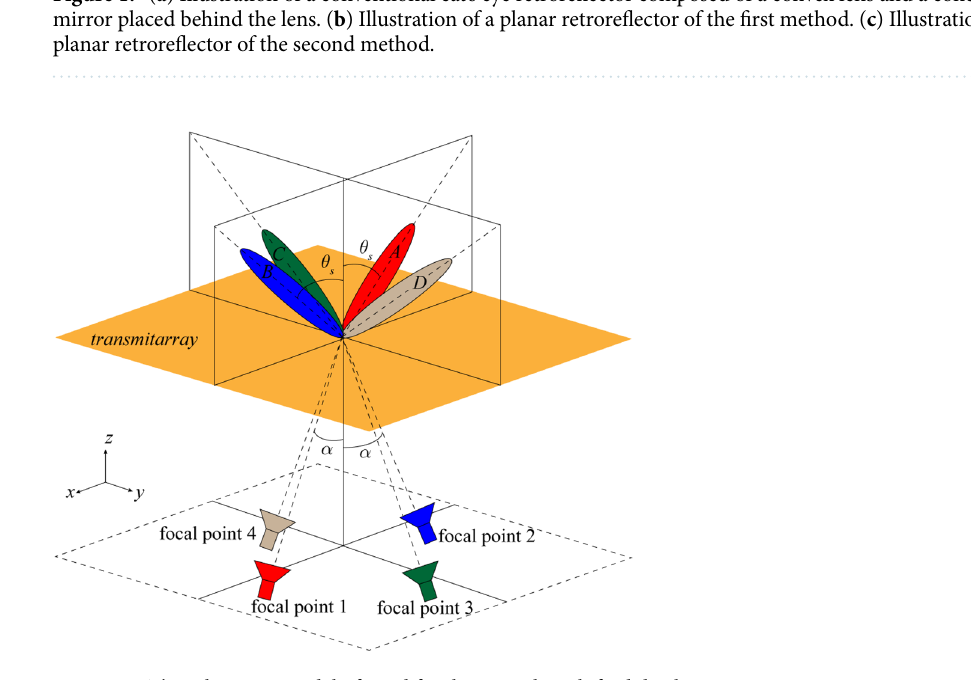
Figure 2. The schematic model of quad focal approach with feed